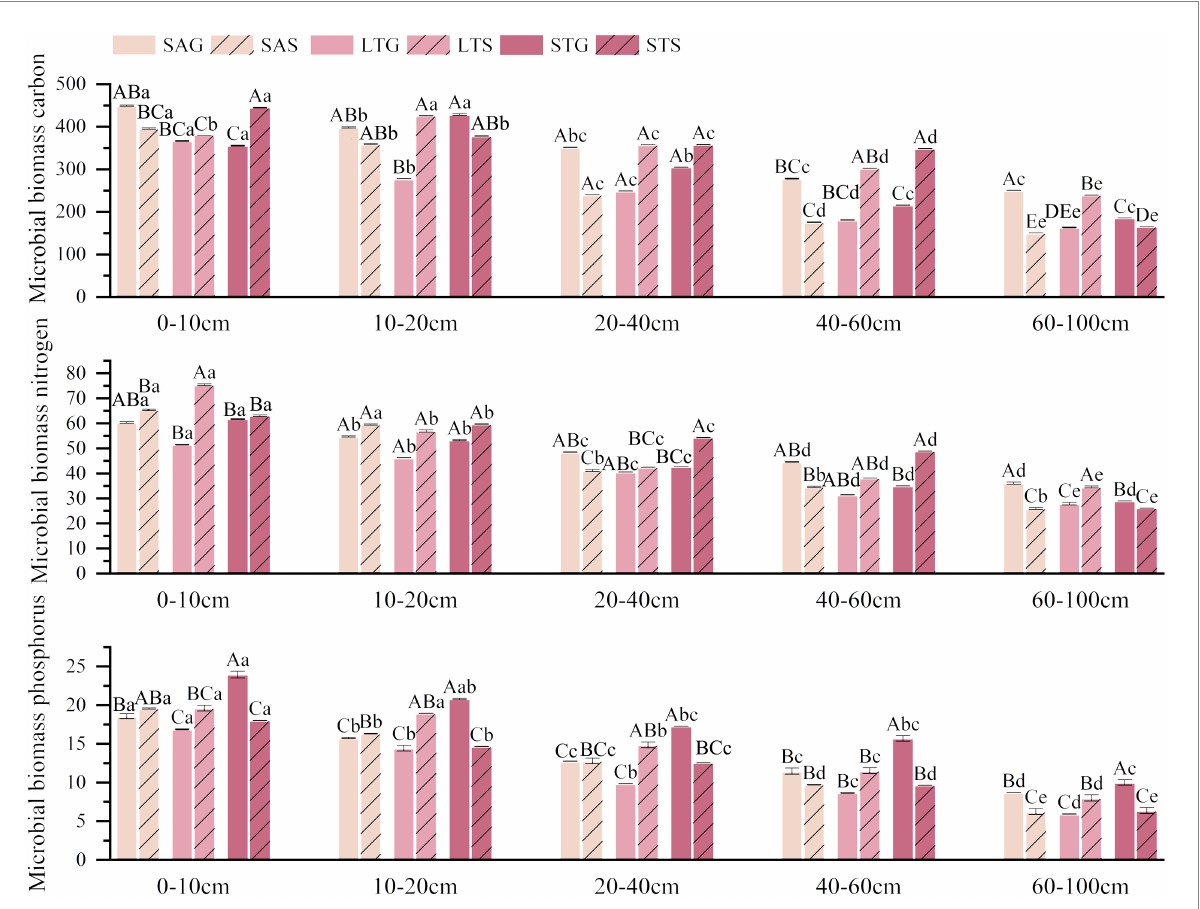
FIGURE 5 Characteristics of soil MBC, MBN and MBP in the 0–100 cm soil profile under three shrub-encroached